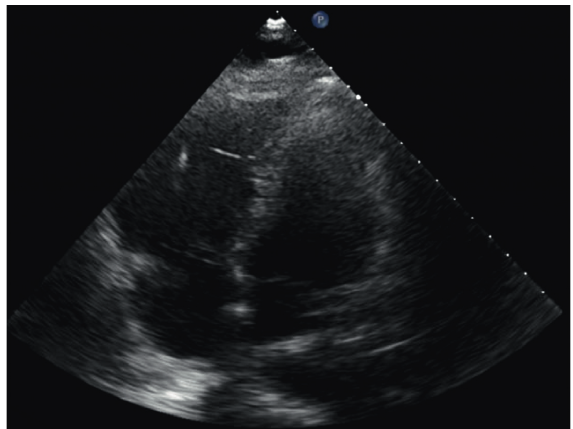
Figure 3: Echocardiogram.